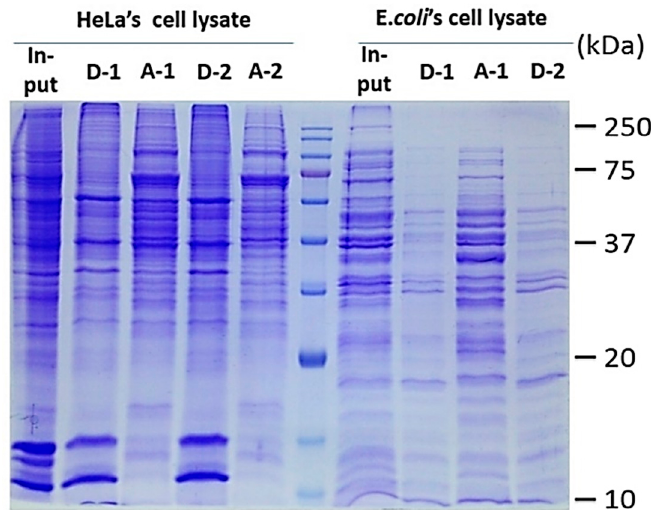
Figure 3. SDS-PAGE analysis of proteins extracted by the SPEED platform following TX-100/H 2 O cloud point extraction from whole cell lysates. D stands for detergent-rich phase, and A for aqueous (detergent-depleted) phase. Lanes marked by “-1” and “-2” represent the absence and presence, respectively, of hydrophobic dye in the phase-separation operation. Input lanes represent the respective whole cell proteome. A-lanes displayed identical patterns as the supernatant from ultracentrifugation. While the PAGE patterns are similar, with or without the aid of phase visualizing dye, recovery of the phases was a much easier task on the operator’s part with its presence.